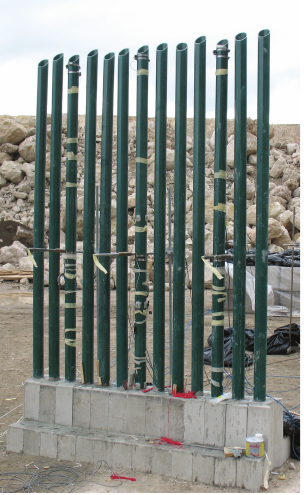
Figure 1: Prototype of the